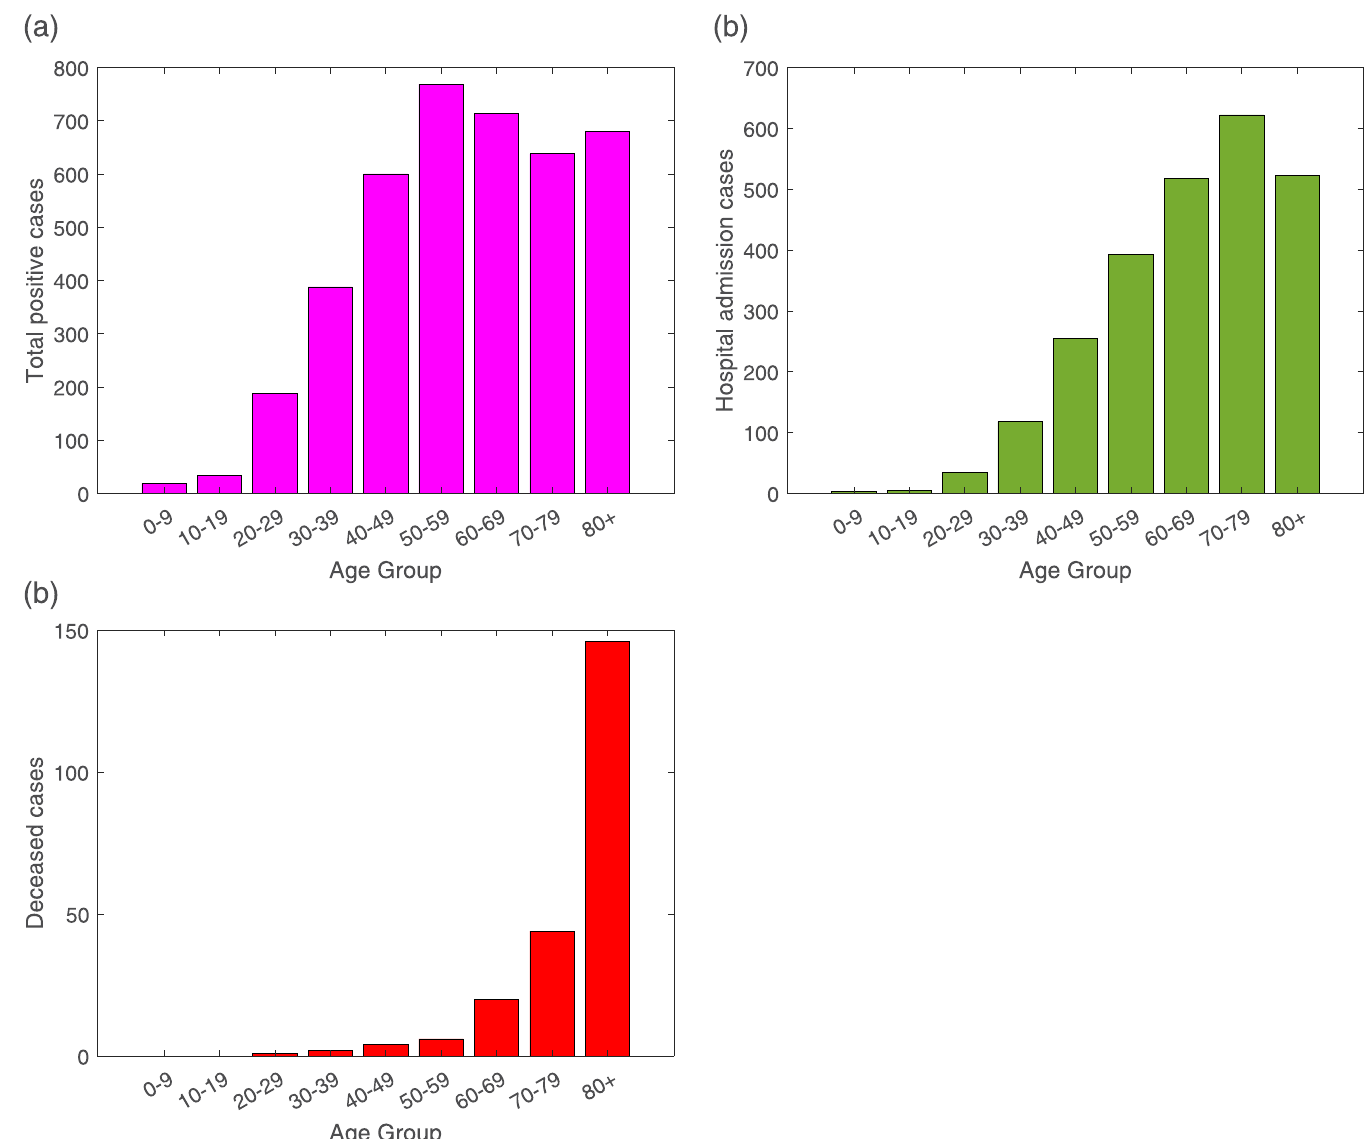
Fig 2. From February 15 to March 25, 2020, raw data distribution for (a) total positive cases, (b) Hospital admission including ICU cases and (c) deceased cases.